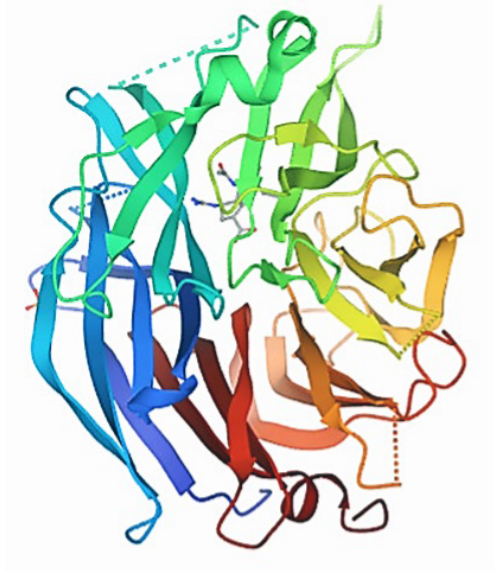
Figure 5. Three-dimensional structure of the protein NQO1 (PDB ID: